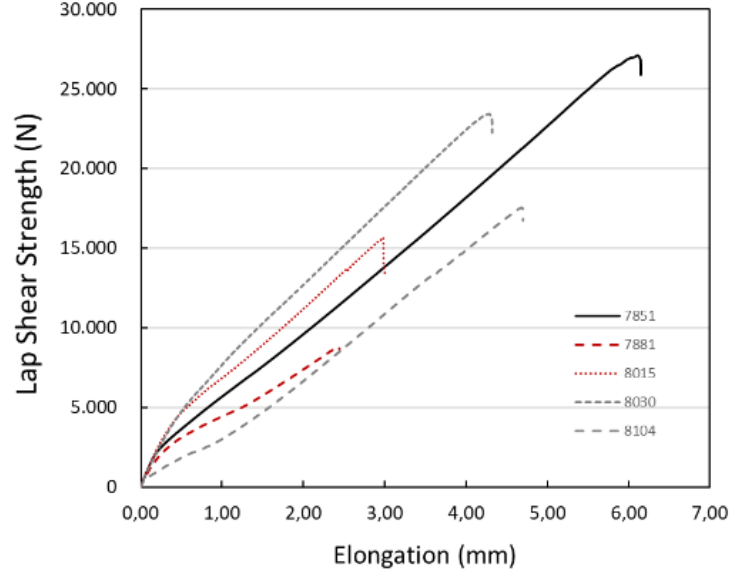
Figure 13. Specimen elongation in the lap shear test.